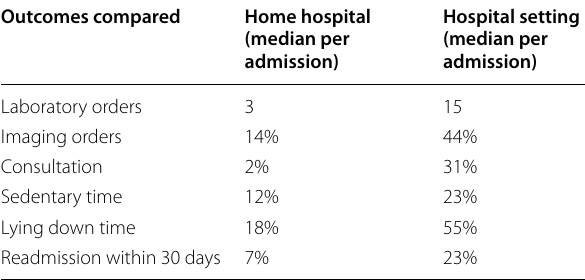
Table 2 Showing outcomes comparison between